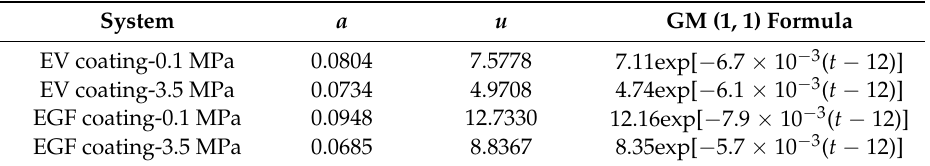
Table 2. The parameters calculated by grey system theory (GST) and the grey model (GM) (1,